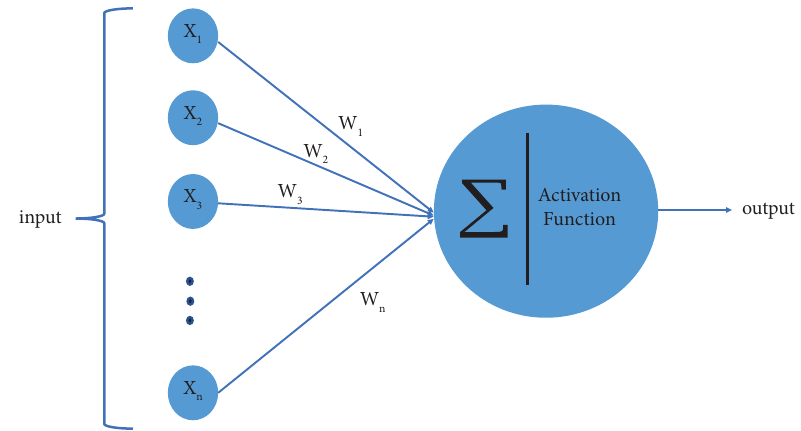
Figure 1: An overview of an artifcial